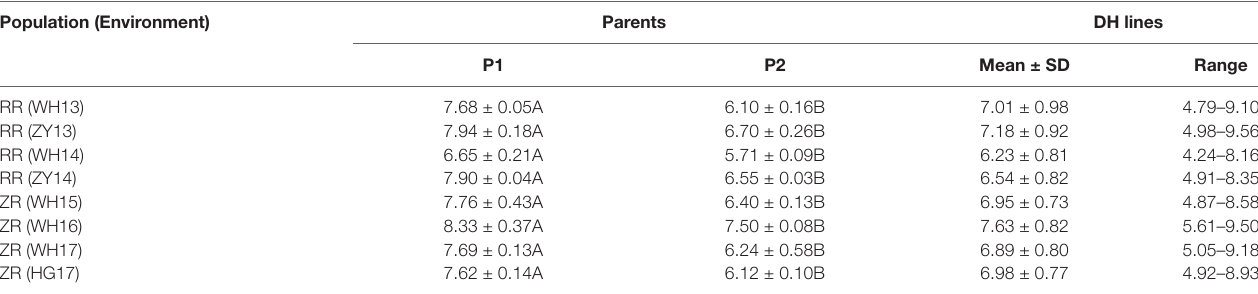
TaBLe 1 | Descriptive statistics on silique length SL (in millimeters) of parents and double-haploid (DH) lines in RR and ZR populations. Population (environment)